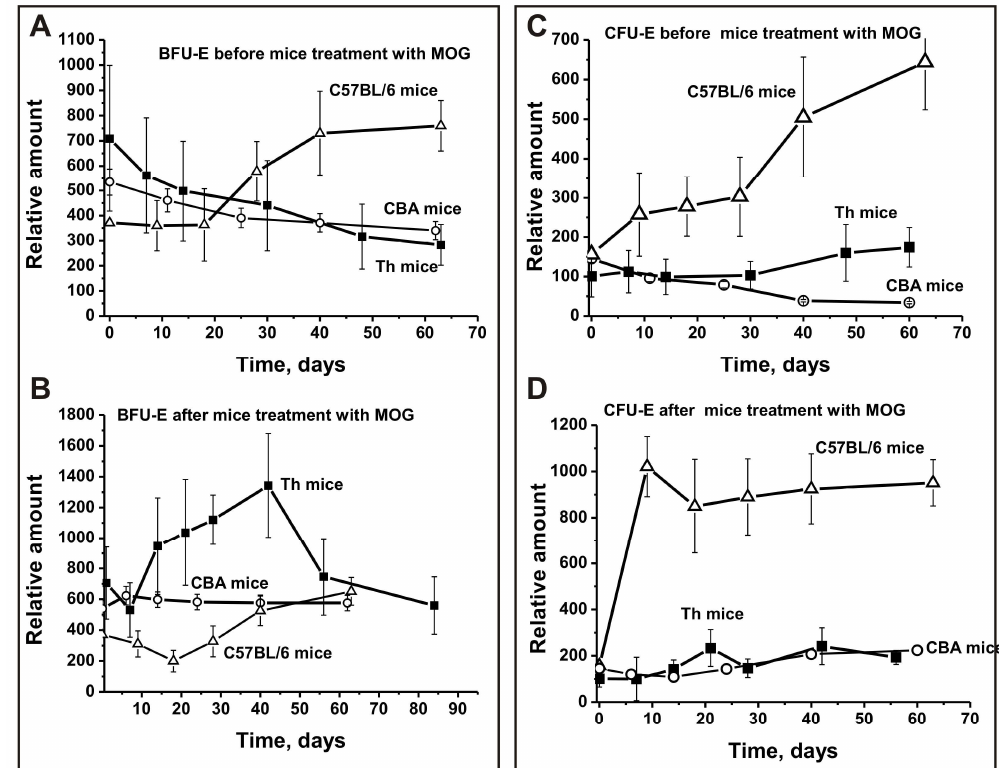
Figure 2. Changes over time in the number of mouse brain BFU-E ( A , B ) and CFU-E ( C , D ) cells before and after MOG treatment of C57BL/6, CBA, and Th mice. BFU-E: erythroid burst-forming unit, early erythroid colonies; CFU-E: erythroid burst-forming unit, late erythroid colonies. In the period before MOG immunization, the relative number of CFU-GM colonies over time increased 1.8-fold for CBA mice and 1.4-fold for C57BL/6 mice, while there was a minimal change for Th mice (Figure 3A). After MOG treatment, CFU-GM cells decreased 1.6-fold in CBA mice, while (Figure 3B). Interestingly, for C57BL/6 mice, the opposite effect was observed—a sharp 1.6-fold